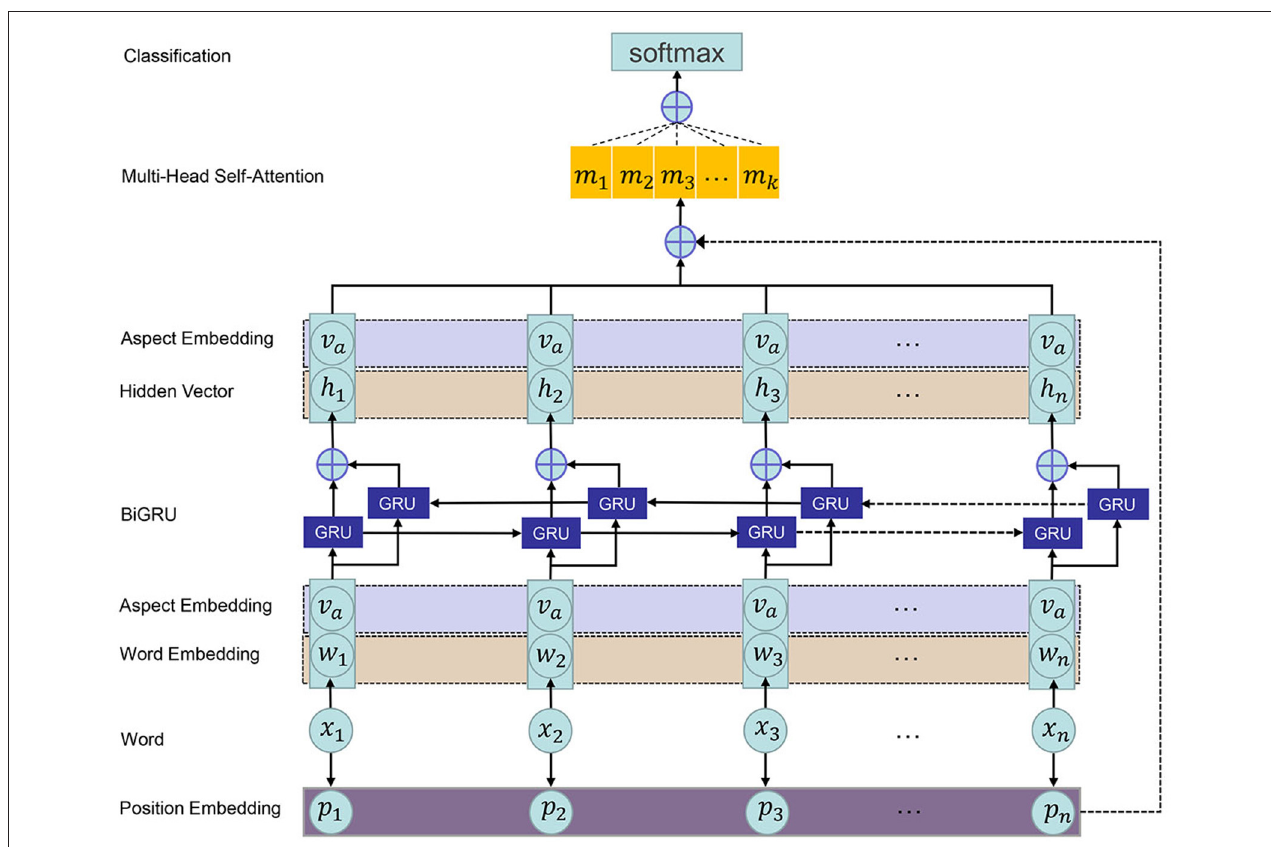
FIGURE 1 | The architecture of the PMHSAT-BiGRU for